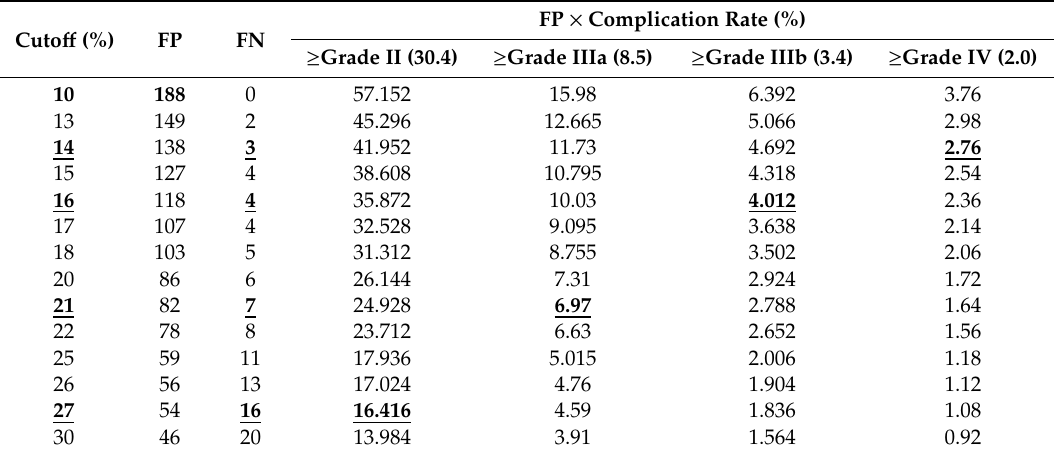
Table 2. Variables of calculation method according to the cuto ff and the severity of complications in the distal pancreatectomy group ( n = 293).